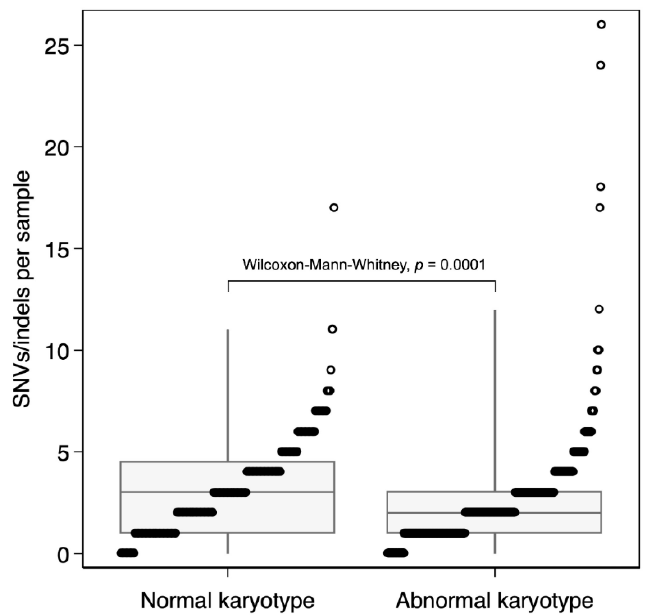
Figure 1. Single nucleotide variant (SNV)/indel mutational burden in pediatric normal vs. abnormal karyotype AML. Total number of SNVs and indels in each sample. The boxplots show the median and interquartile ranges (box) with the 1st and 99th percentiles (whiskers).